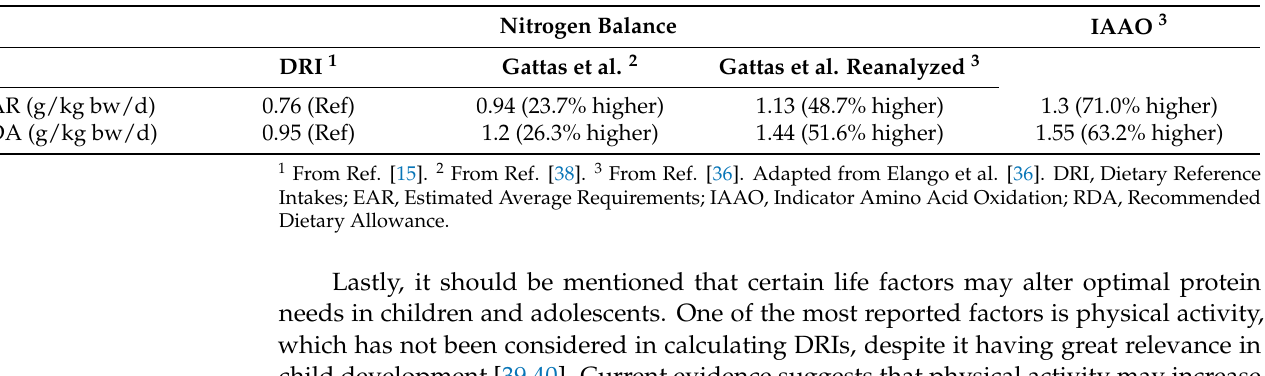
Table 2. Comparison of protein requirements in children 6–10 years